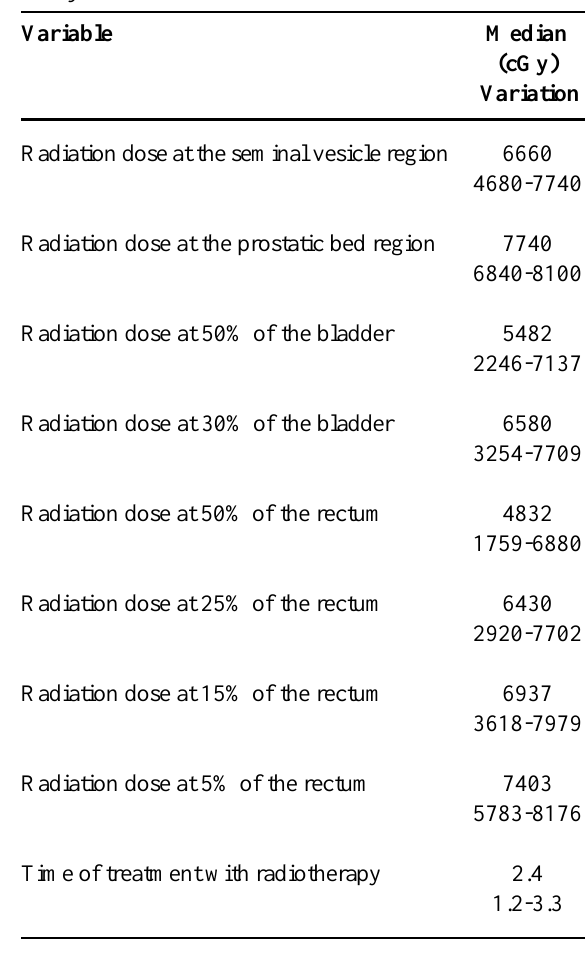
Table 2 – Characteristics of salvage conformal radio- therapy in biochemical recurrence after radical prostate-